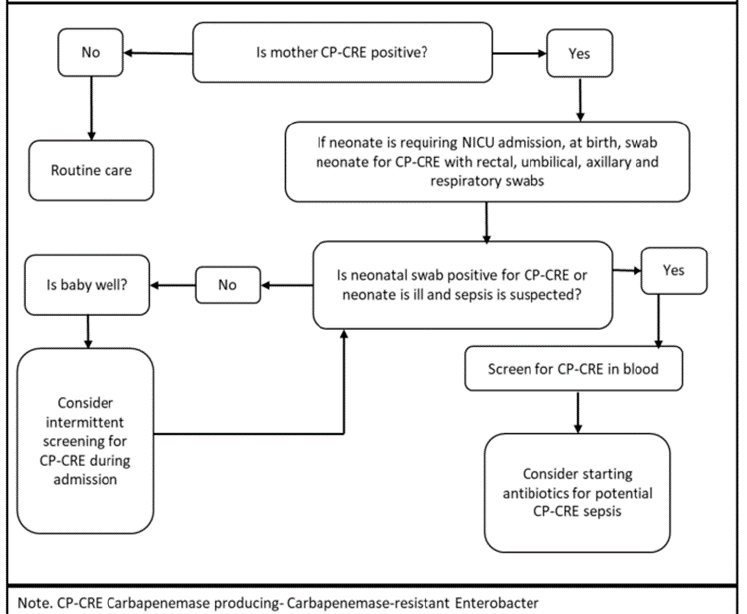
Figure 5. Carbapenemase-producing, carbapenem-resistant Enterobacteriaceae infection and control in neonates admitted to the NICU.